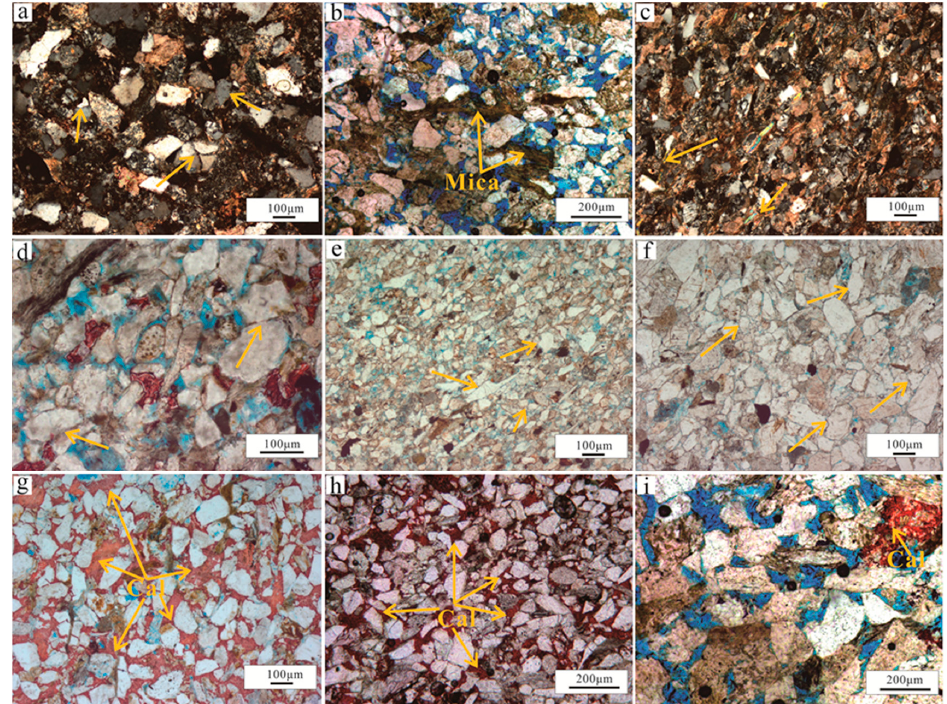
Figure 7. Thin-section photomicrographs showing compaction and calcite cement features. ( a ) Grain contacts present dominated by linear types (yellow arrow) due to the influence of compaction, cross-polarized light (CPL). ( b ) Mechanical compaction is identified by deformation of mica, plane-polarized light (PPL). ( c ) Deformation of mica and ductile grains resulting in the formation of a pseudomatrix (yellow arrow), CPL. ( d ) Grain contacts characterized by long contacts (yellow arrow), PPL. ( e ) Grain contacts characterized by long and concavo-convex contacts (yellow arrow), PPL. ( f ) Chemical compaction evidenced by grain rearrangements with concavo-convex contacts (yellow arrow), PPL. ( g ) Calcite cements filling between loosely packed grains, PPL. ( h ) As a result of the amount of calcite cements filling in the pores, the clastic grains appear to be floating, PPL. ( i ) Calcite cements represented the partial replacement of grains and filling in the intergranular pores, PPL. Cal: calcite.